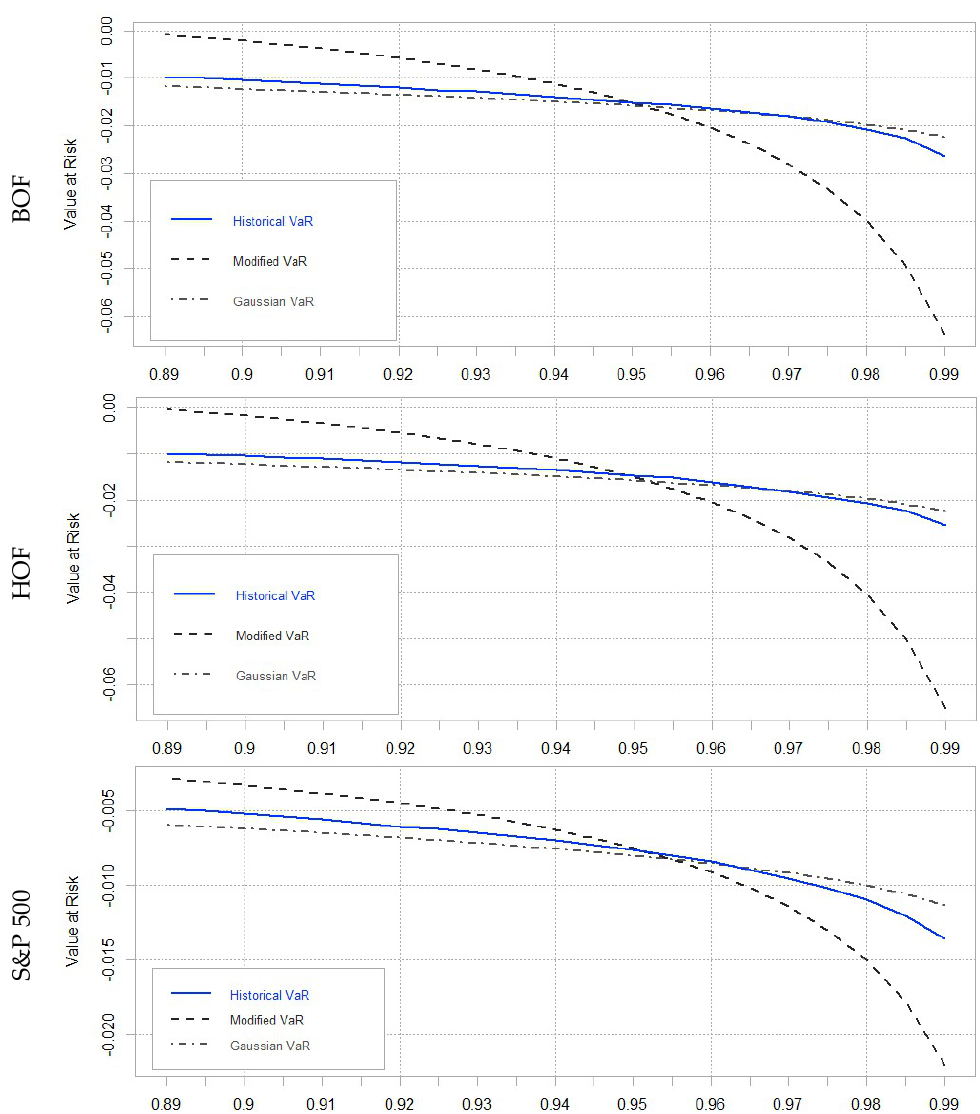
Figure 4. VaR results of the Variables.